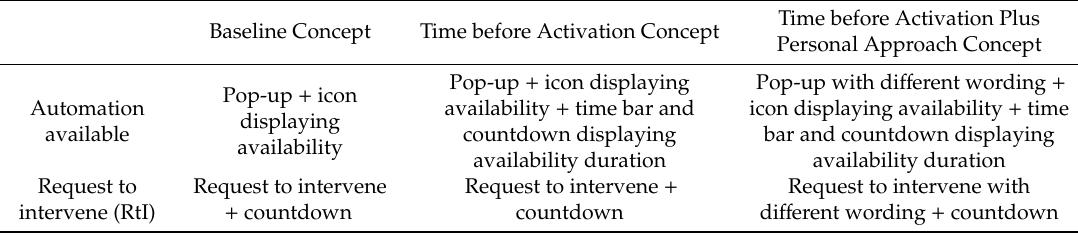
Table 1. Di ff erent information displayed in the Human–Machine Interface (HMI)